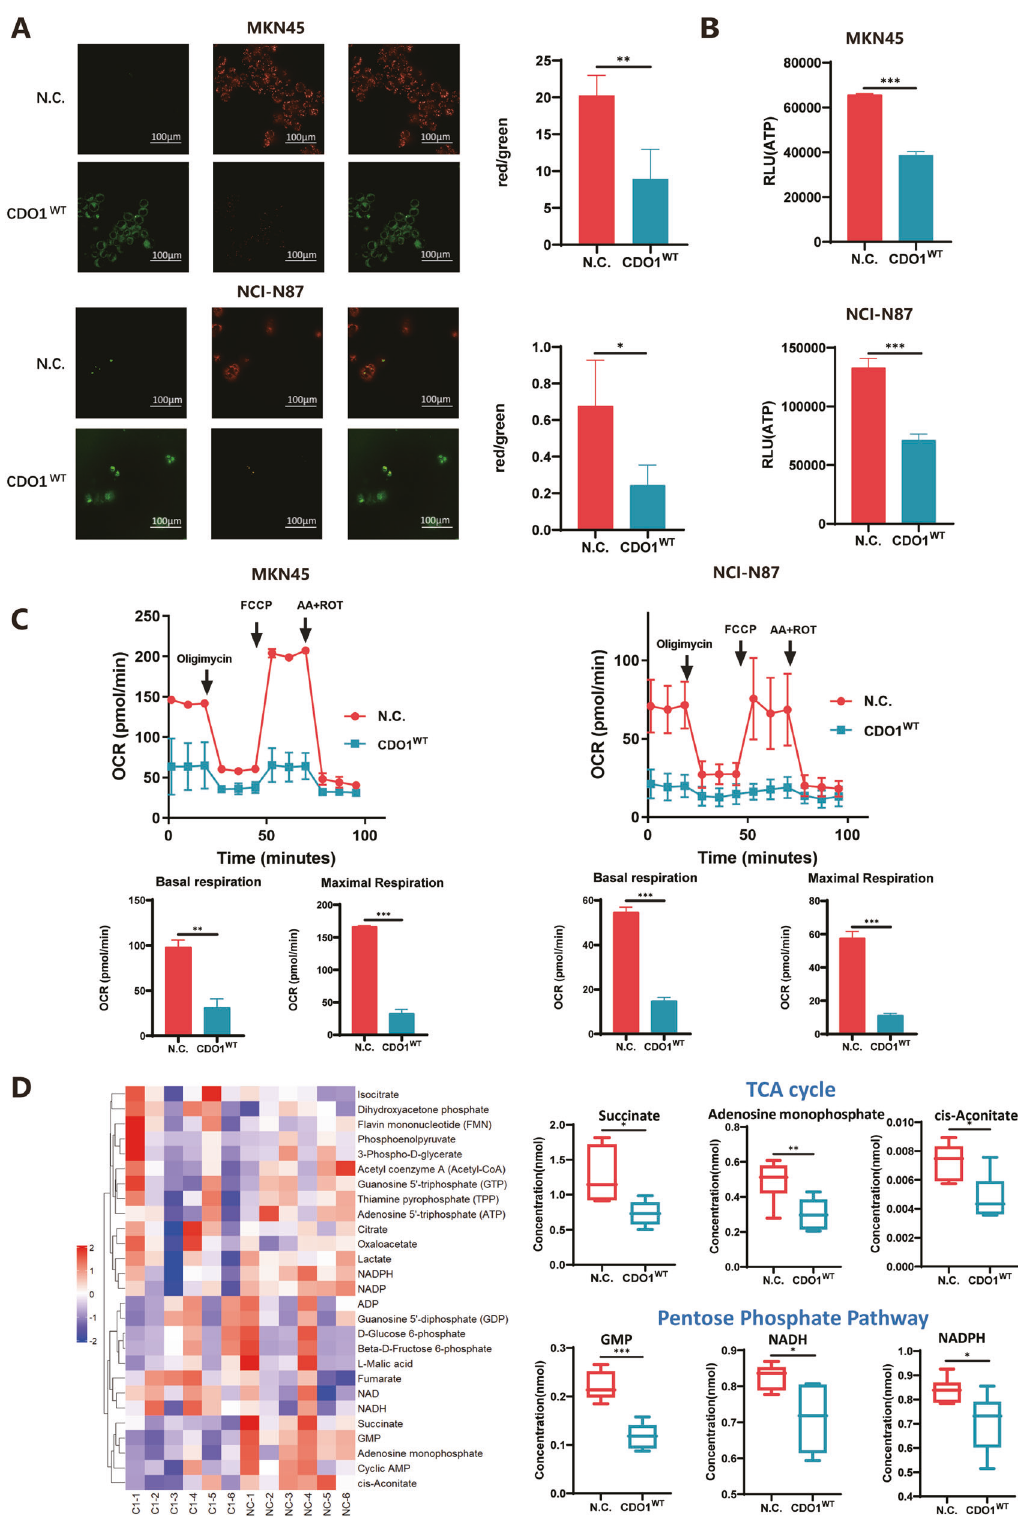
severe oxidative stress in cells. Together, these results show that the imbalanced redox state that was triggered by CDO1 hampered the function of